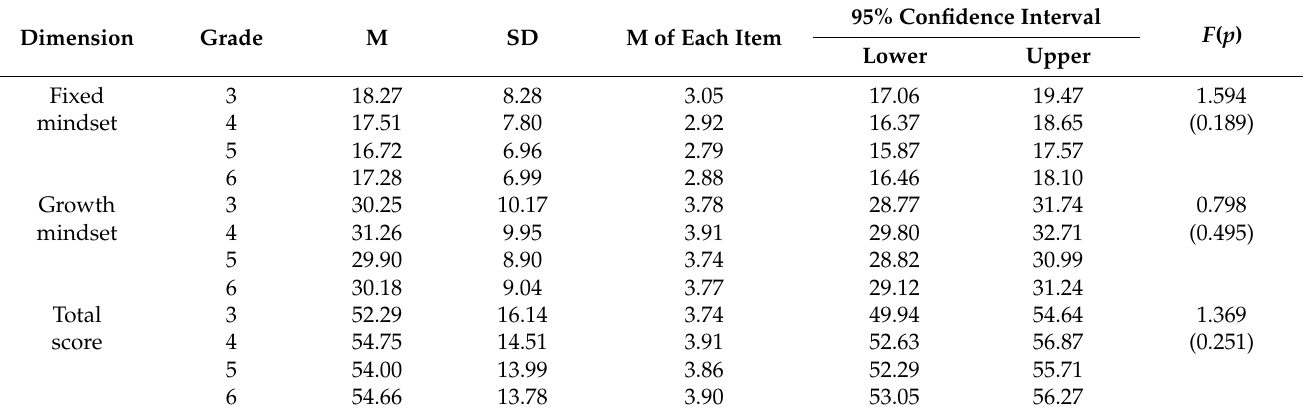
Table 4. The difference in cognitive mindset by